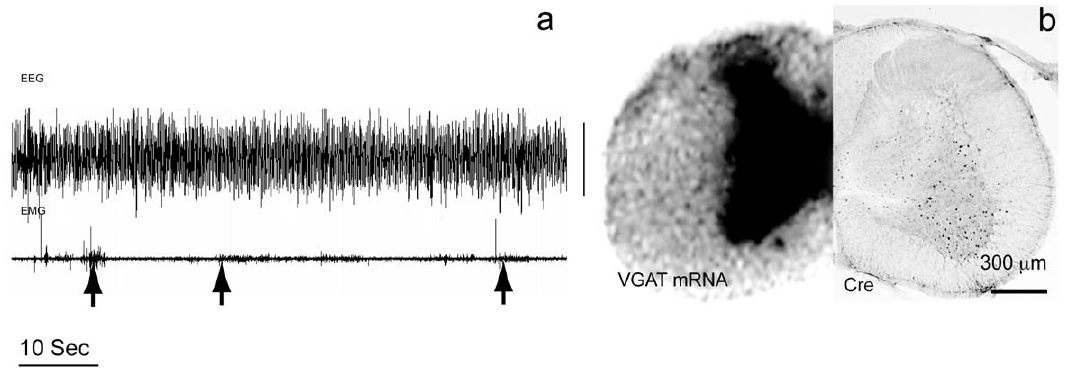
Figure 7. VGAT knockout in the spinal cord produces REM without atonia. ‘‘a’’ shows the absence of atonia (arrow points at twitches) during a REM sleep segment (high theta EEG) in a mouse with Vgat knockout in the C3–C4 ventral horn region (also see supplementary Video S2). ‘‘b’’ shows the Cre-labeled neurons (right side) in the ventral horn and loss of VGAT mRNA in the corresponding region (left). The calibration bar is 200 m V.